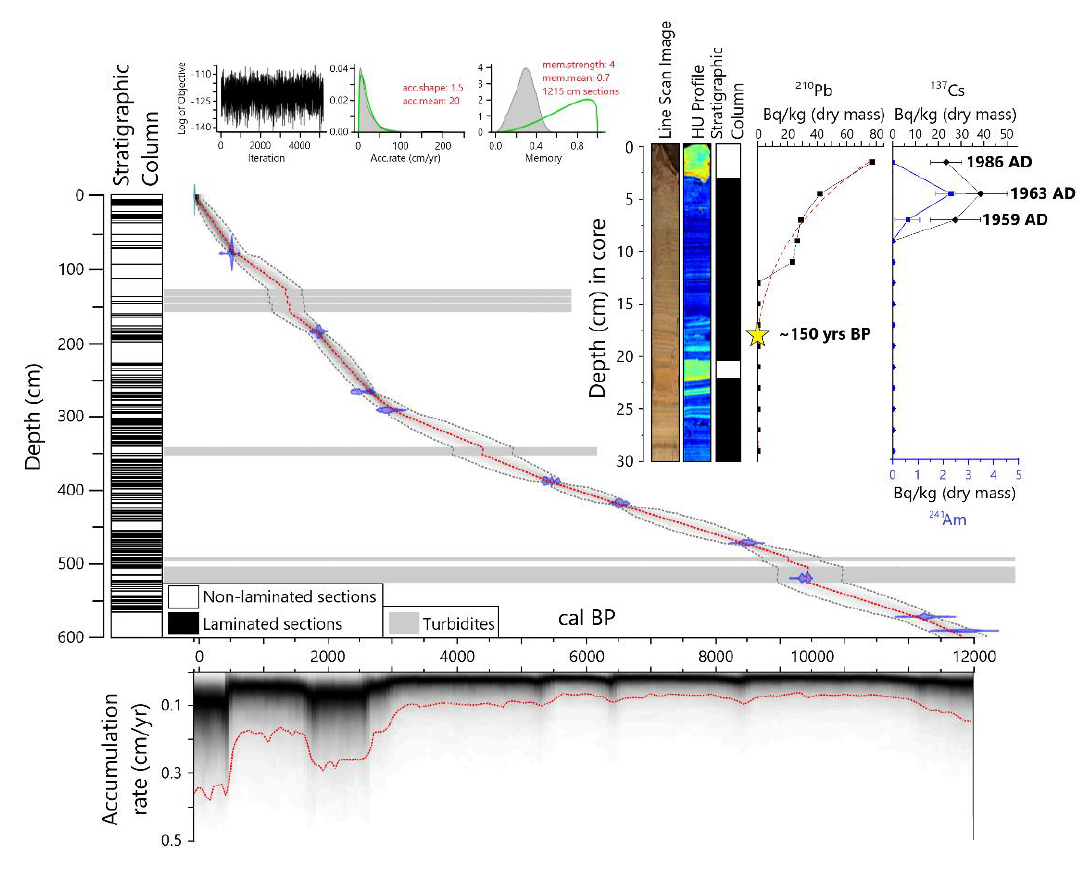
Figure 7. Bayesian age-depth model and accumulation rates constructed using the R package rbacon [94] with defined laminated sections presented to the left. Identified turbidite deposits respond to the gray-colored sections. Radionuclide results are presented on the top right, including 210 Pb, 137 Cs and 241 Am profiles, in comparison with the HU model and the simplified stratigraphy of the sediment sequence (0–30 cm